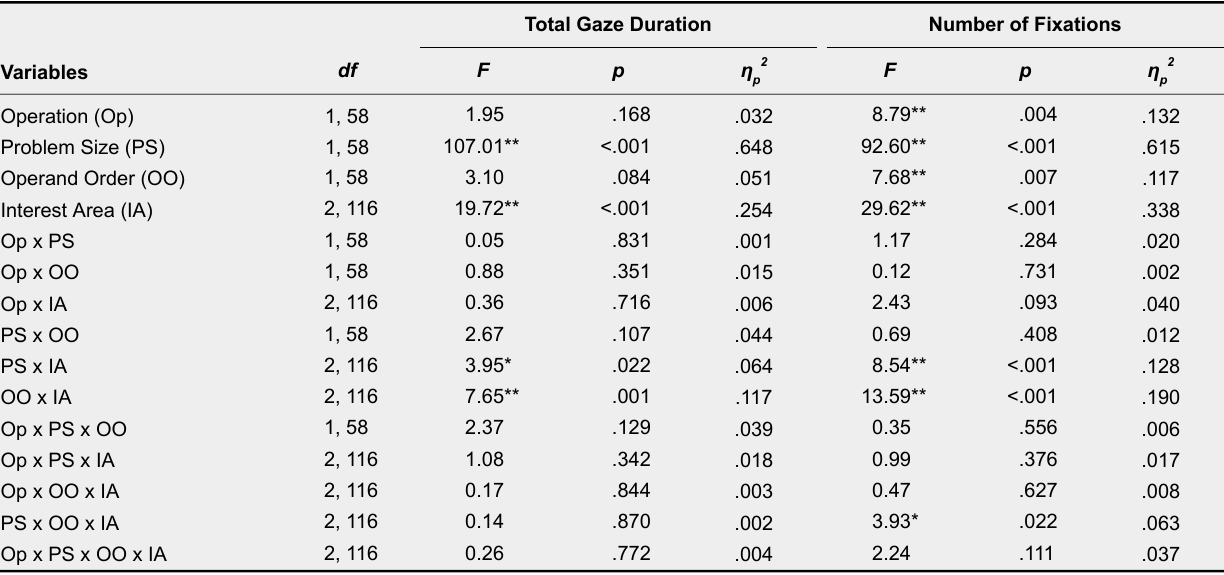
Statistical Analyses of Number of Fixations and Total Gaze Duration for Addition and Multiplication, Including Operand Order as a Factor